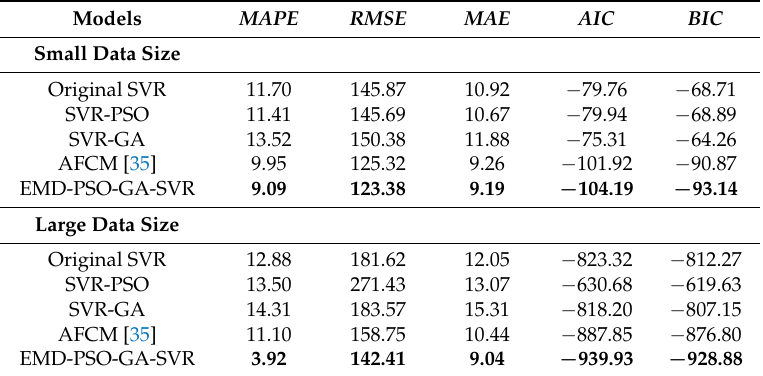
Table 7. Forecasting performances of competitive models for both small and large data sizes (Example 1).